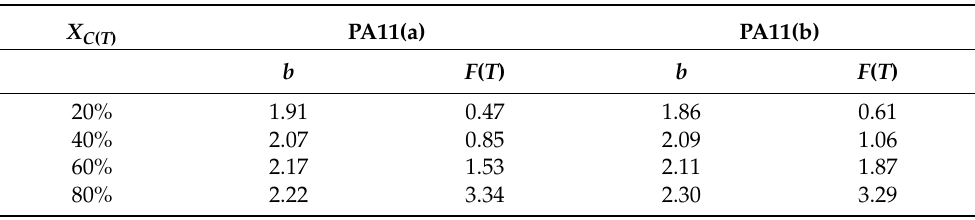
Table 3. The values of b and F ( T ) at different relative